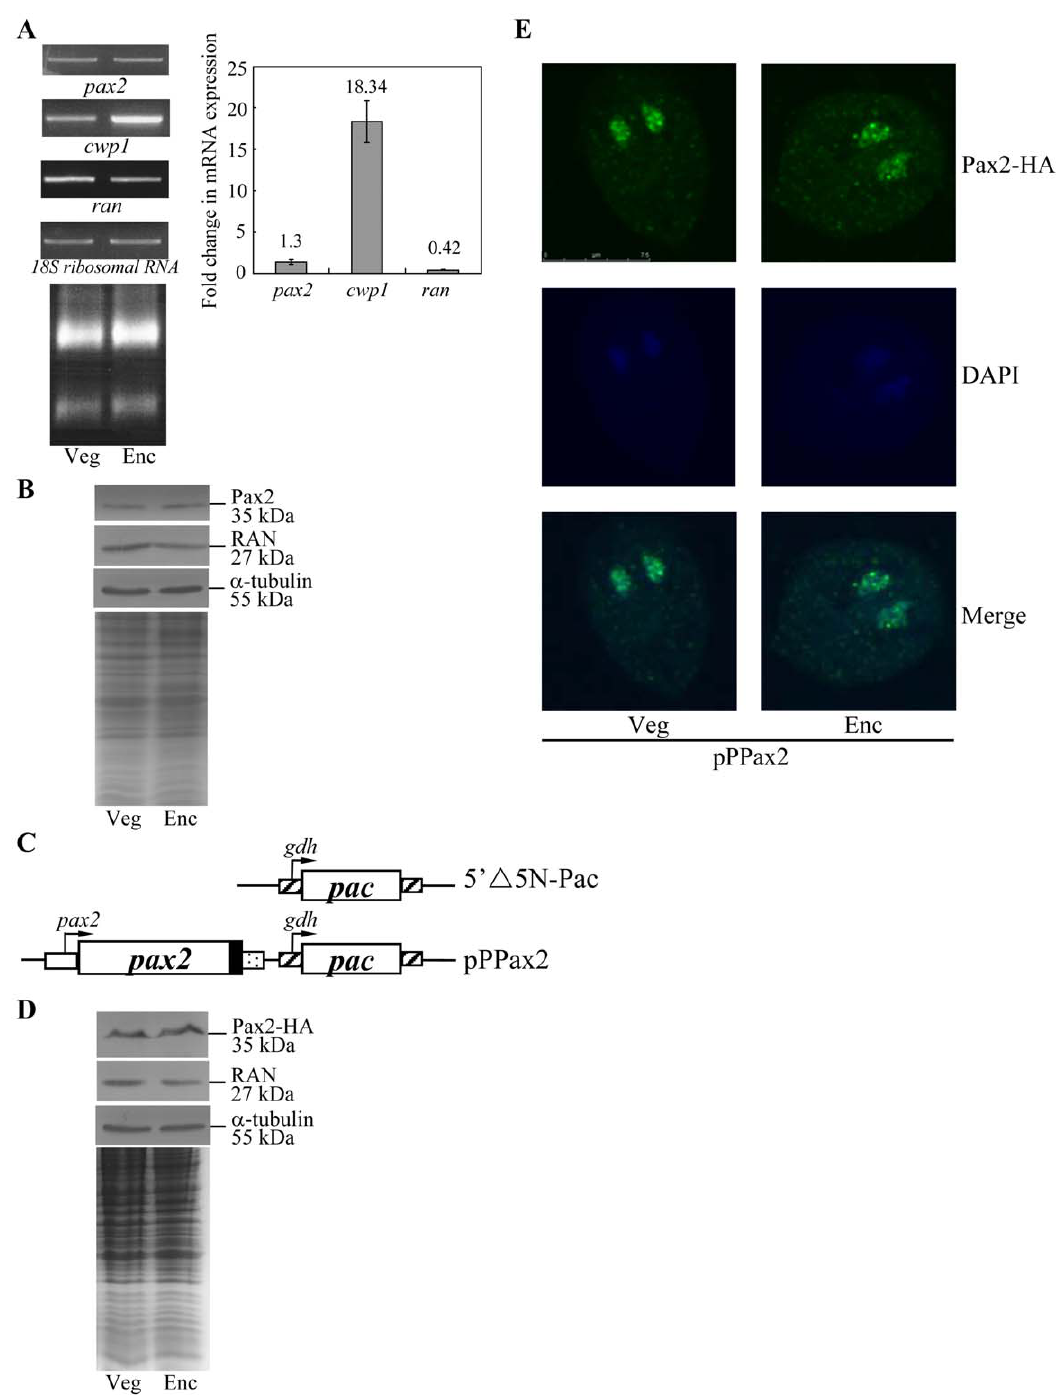
Figure 2. Analysis of pax2 gene expression. (A) RT-PCR and quantitative real-time PCR analysis of pax2 gene expression. RNA samples were prepared from G. lamblia wild-type non-transfected WB cells cultured in growth (Veg, vegetative growth) or encystation medium and harvested at 24 h (Enc, encystation). RT-PCR was performed using primers specific for pax2 , cwp1 , ran , and 18S ribosomal RNA genes. Ribosomal RNA quality and loading controls are shown in the bottom panel. Representative results are shown on the left. Real-time PCR was performed using primers specific for pax2 , cwp1 , ran and 18S ribosomal RNA genes. Transcript levels were normalized to 18S ribosomal RNA levels. Fold changes in mRNA expression are shown as the ratio of transcript levels in encysting cells relative to vegetative cells. Results are expressed as the means 6 standard error of at least three separate experiments (right panel). (B) Pax2 protein levels in different stages. The wild-type non-transfected WB cells were cultured in growth (Veg, vegetative growth) or encystation medium for 24 h (Enc, encystation) and then subjected to SDS-PAGE and Western blot. The blot was probed by anti-Pax2, anti-RAN, or anti- a tubulin antibody. Representative results are shown. Equal amounts of protein loading were confirmed by SDS-PAGE and Coomassie blue staining. (C) Diagrams of the 5 9 n 5N-Pac and pPPax2 plasmid. The pac gene (open box) is under the control of the 5 9 - and 3 9 - flanking regions of the gdh gene (striated box). In construct pPPax2, the pax2 gene is under the control of its own 5 9 -flanking region (open box) and